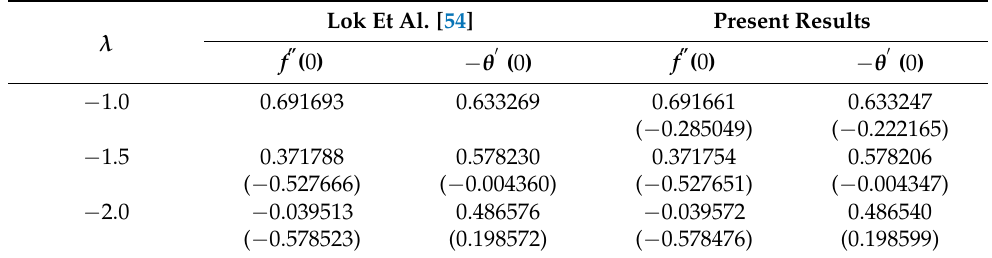
Table 3. Values of f (cid:48)(cid:48) ( 0 ) and − θ (cid:48) ( 0 ) when ϕ hnf = 0 (regular fluid), Pr = 0.7 and K → ∞ for different λ . Lok Et Al. [54] Present λ